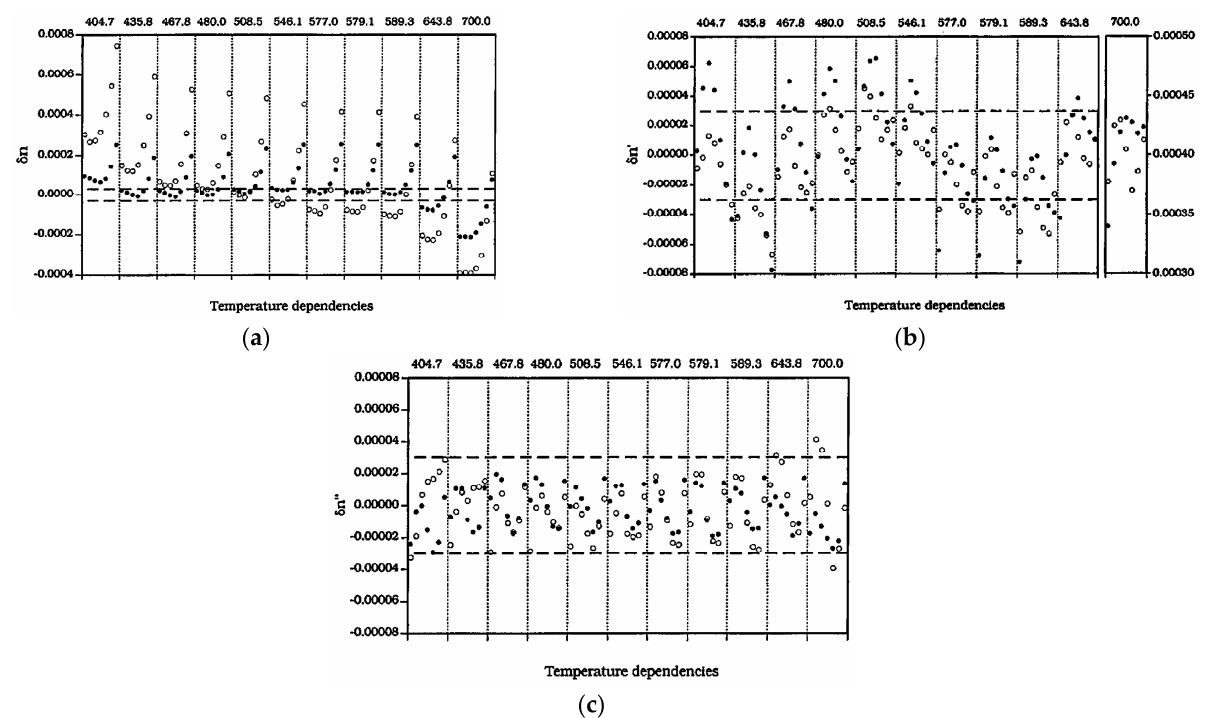
Figure 2. 3 Empirical formula error distribution [22]. ( a ) The first equation. ( b ) The second equation. ( c ) The third equation.